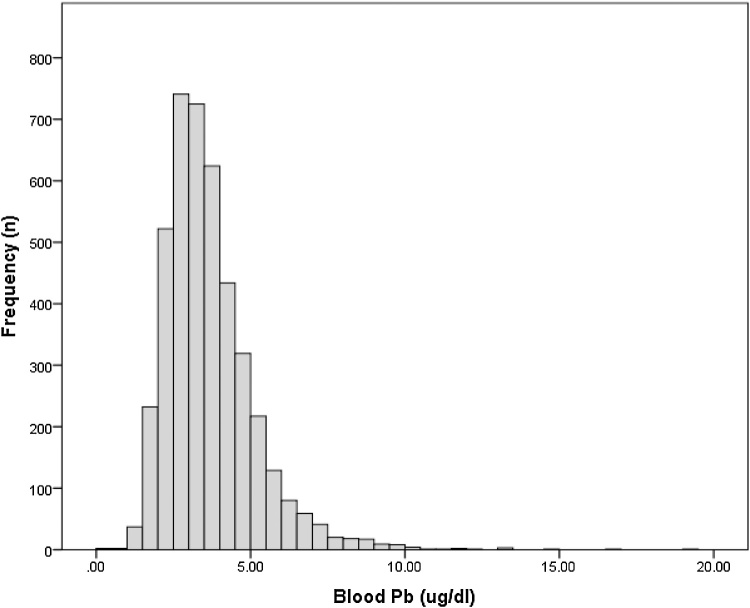
Frequency distribution of B-Pb levels in pregnancy (n = 2451 women who had live births) in ALSPAC.